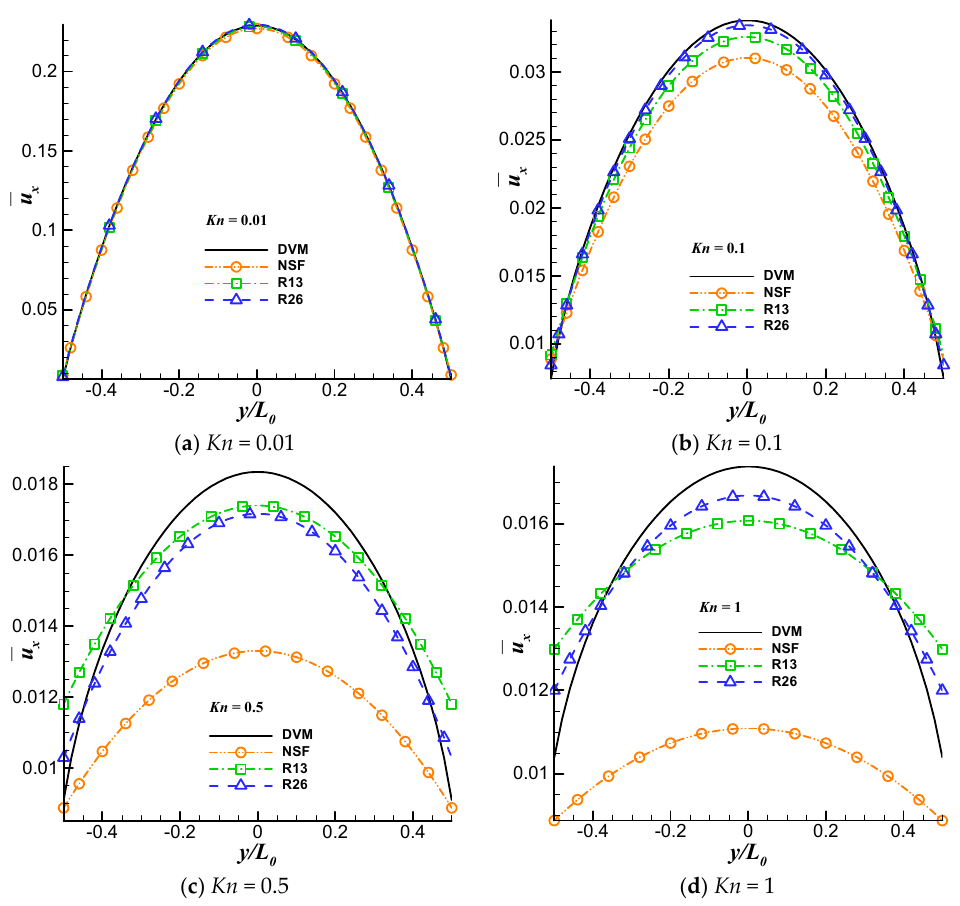
√ Figure 1. Normalized velocity u x = u x / 2 RT 0 profiles along the channel cross-section at ( a ) Kn = 0.01; Figure 1. Normalized velocity 0 2 x x u u / RT = profiles along the channel cross-section at ( a ) Kn = ( b ) Kn = 0.1; ( c ) Kn = 0.5; ( d ) Kn = 0.01; ( b ) Kn = 0.1; ( c ) Kn = 0.5; ( d ) Kn = 1.